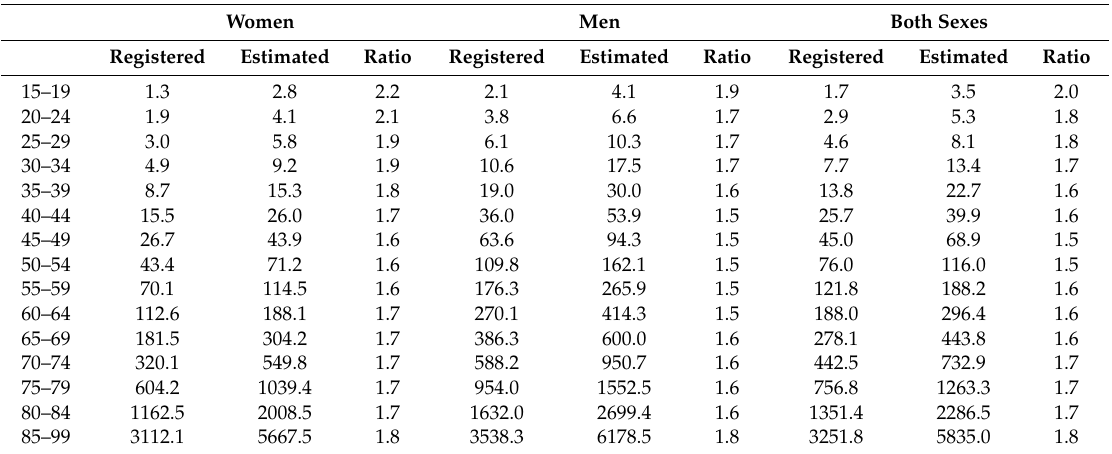
Table A4. Mortality rates of registered and estimated deaths of cardiovascular diseases by sex and age. Women